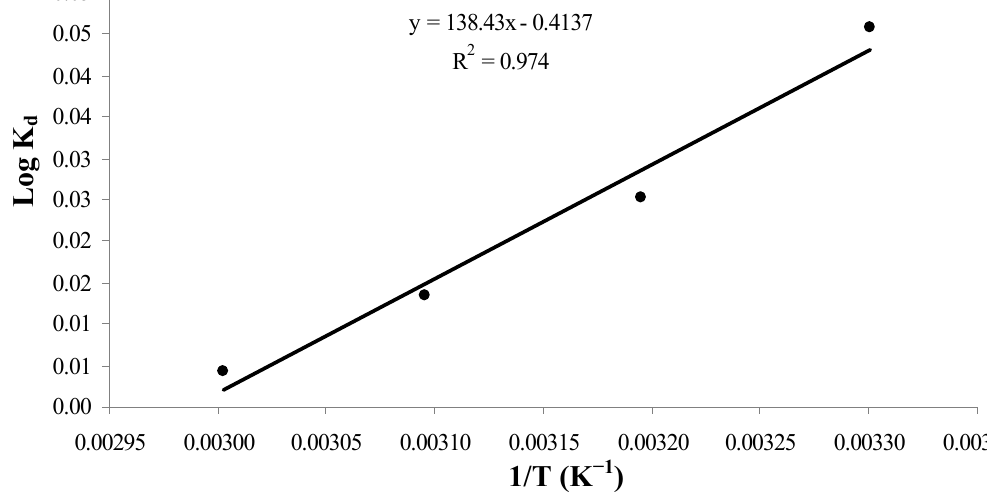
Figure 8. Thermodynamic study of adsorption of Cd(II) onto maleic acid-treated Tamrix articulata wastes.